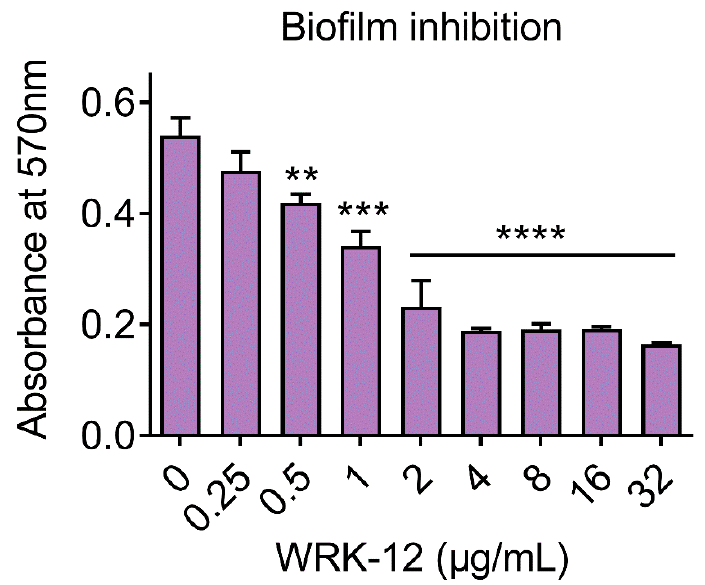
Figure 8. WRK-12 inhibits the formation of E. coli 1F28 biofilm in a concentration-dependent manner. Data were shown as mean ± SD from three independent experiments. ** p < 0.01, *** p < 0.001, **** p < 0.0001, determined by non-parametric one-way ANOVA.